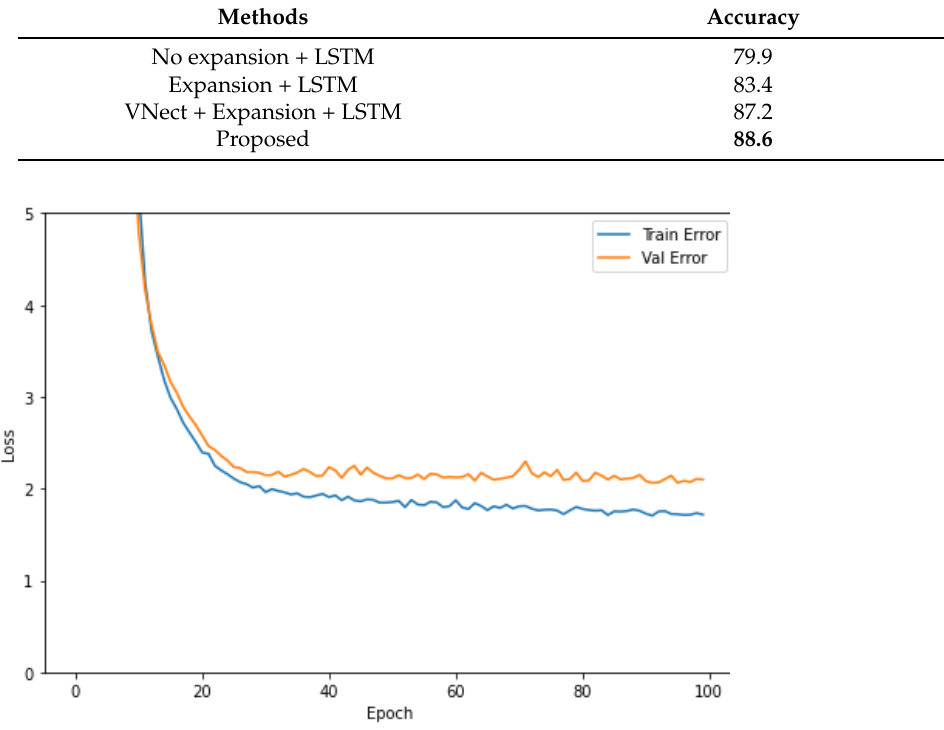
Figure 11. Loss function value during